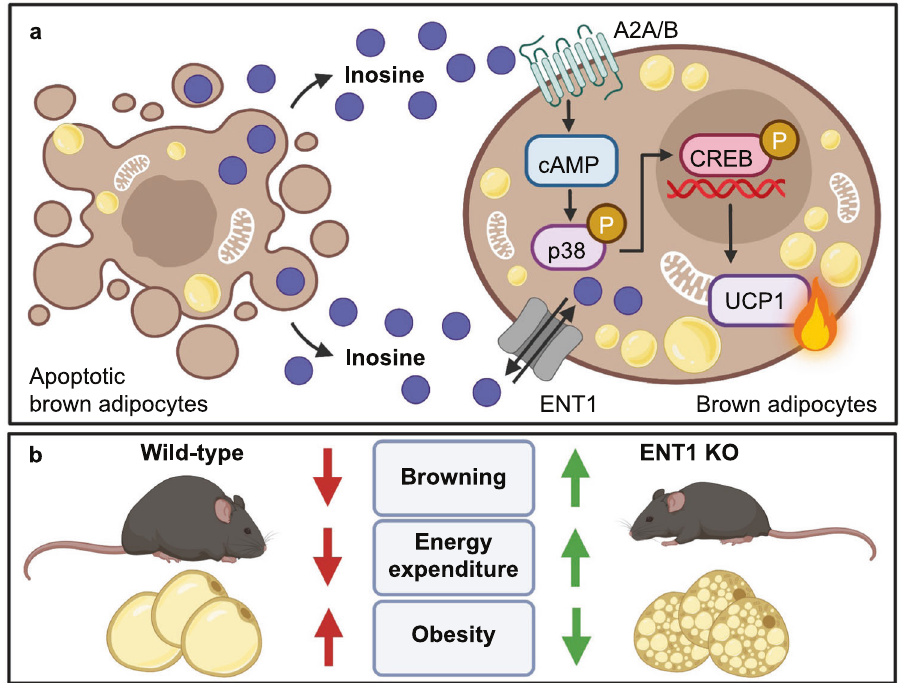
Fig. 1 Inosine is a thermogenic stench of death. a Inosine released by apoptotic brown adipocytes activates adenosine-2A and -2B receptors (A2A/A2B), stimulating thermogenesis via the cAMP-p38 axis. ENT1 is an inosine transporter that regulates extracellular inosine concentrations. b In vivo, ENT1 KO in transgenic mice is associated with higher energy expenditure and browning of adipose tissues as well as protection from obesity. The fi gure was created with